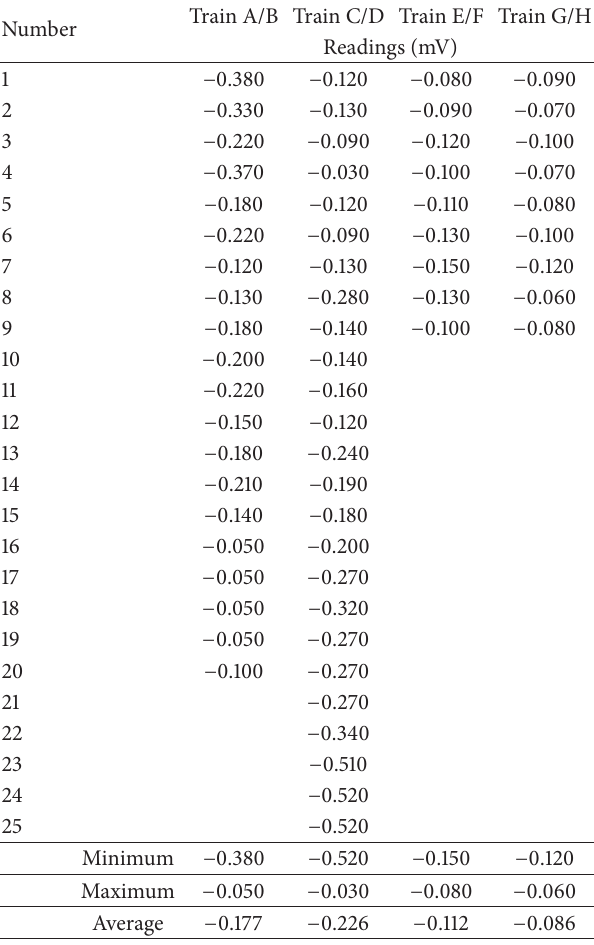
Table 7: Half-cell potential measurement of